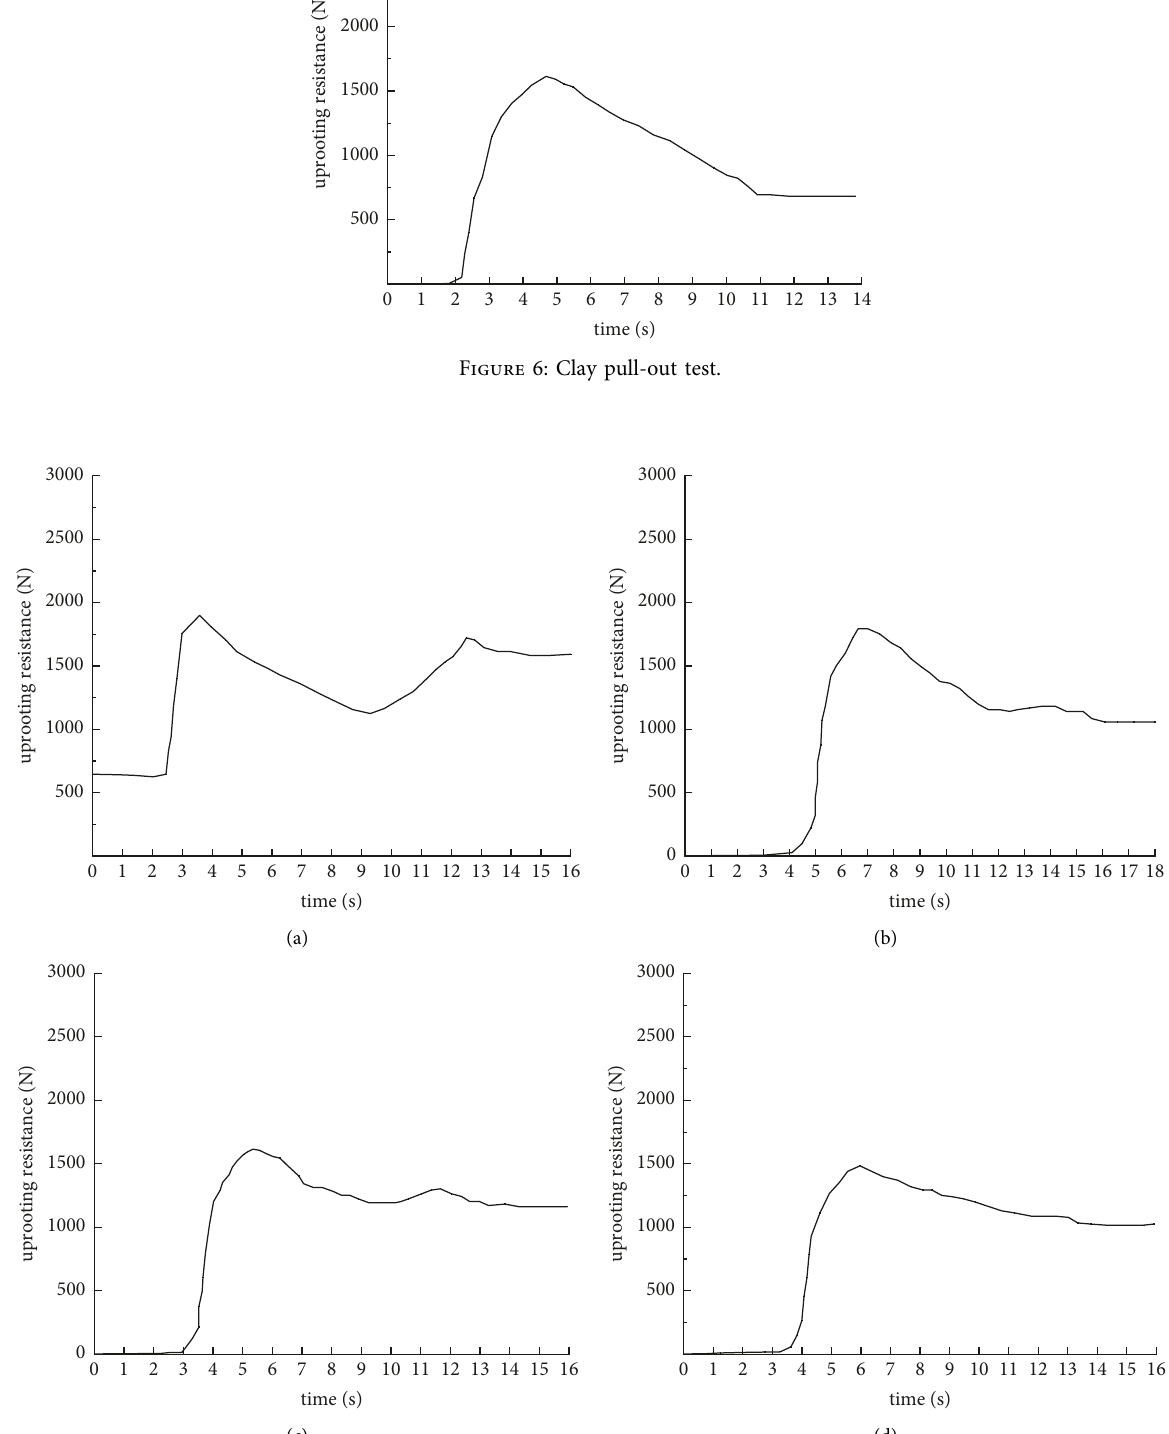
Figure 7: Clay matrix, single-layer stone test results. (a) Test 1-1. (b) Test 1-2. (c) Test 1-3. (d) Test 1-4.